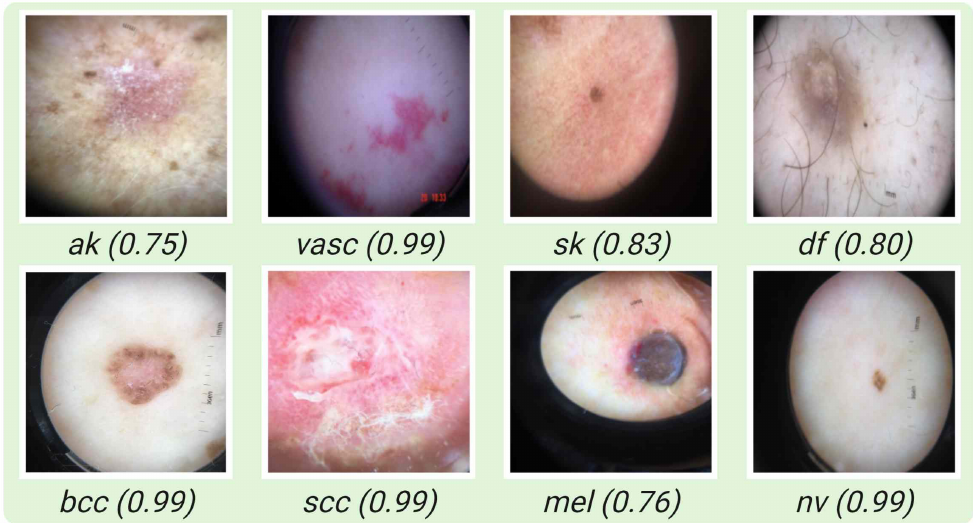
Figure 5. Samples of correctly classified images with their corresponding